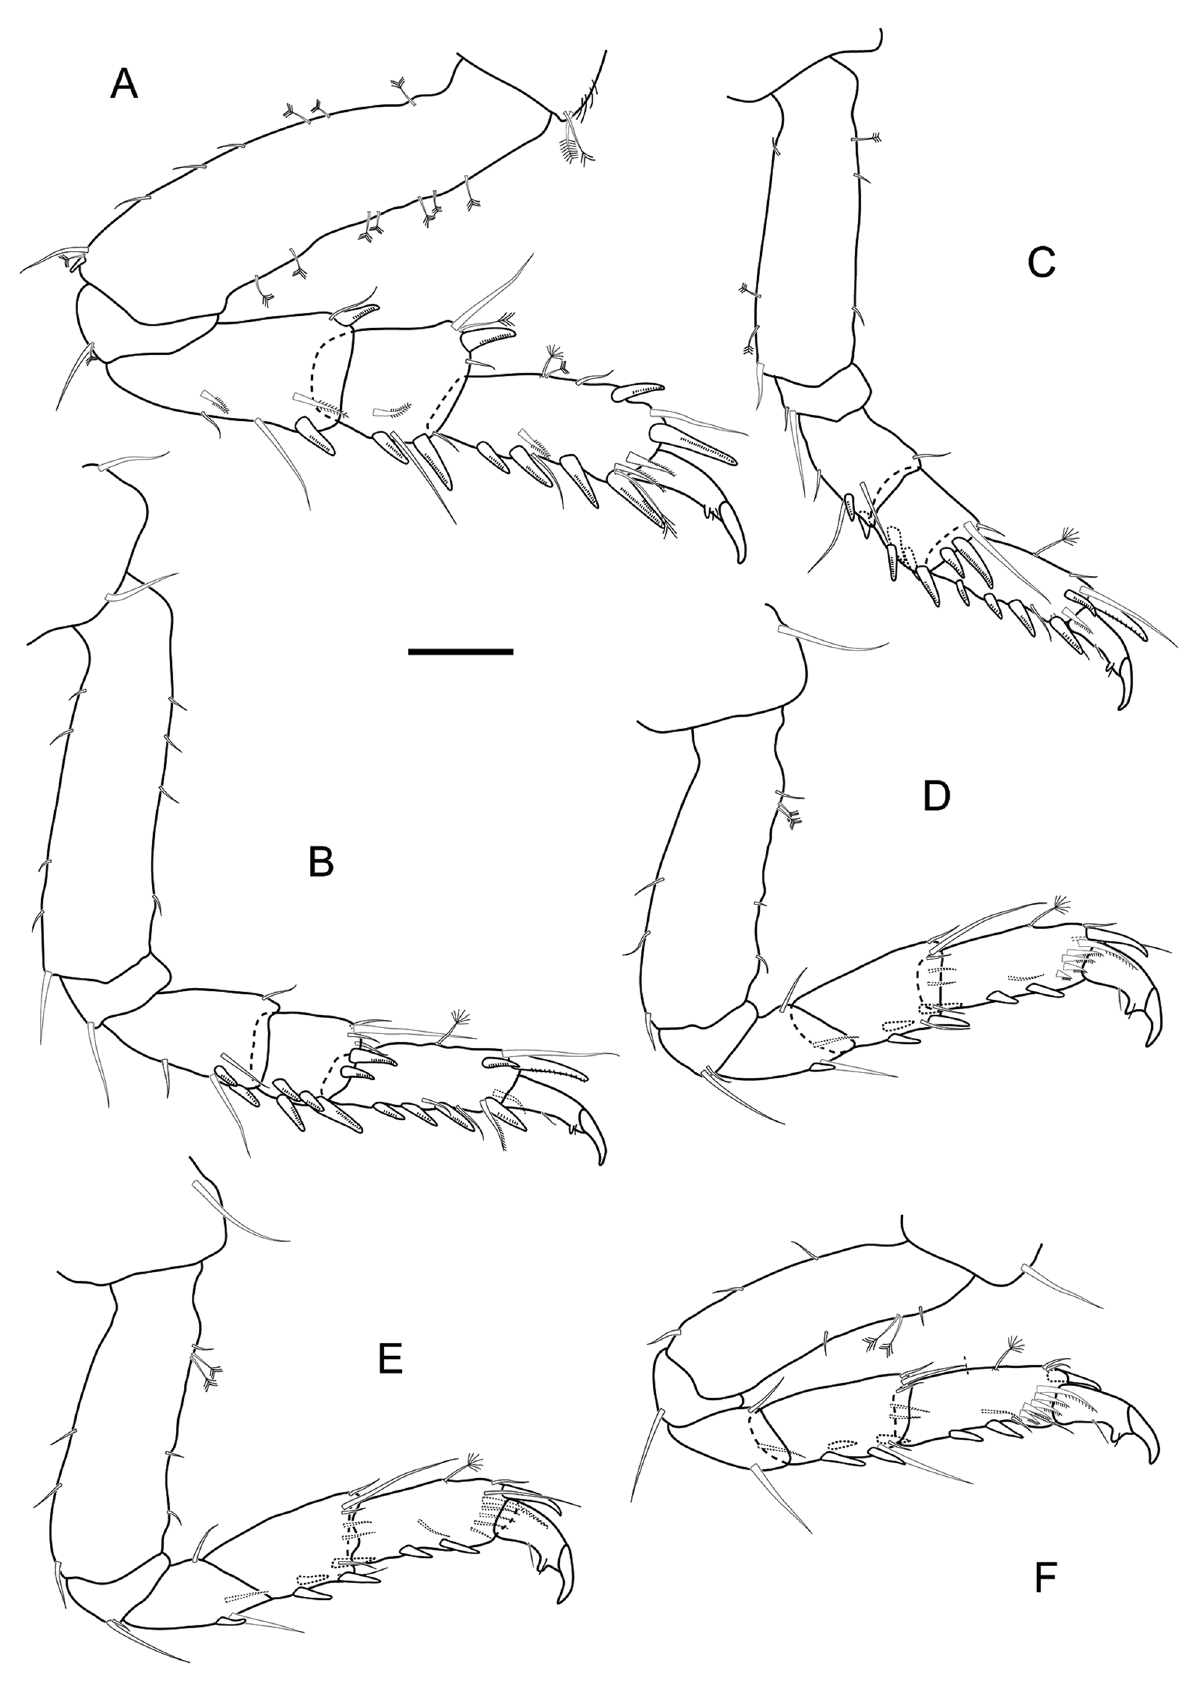
Figure 6. Apseudomorpha brasiliensis sp. nov. Paratype, ovigerous female dissected (MNRJ 29857). A–F Pereopods 1–6. Scale bar: 0.1